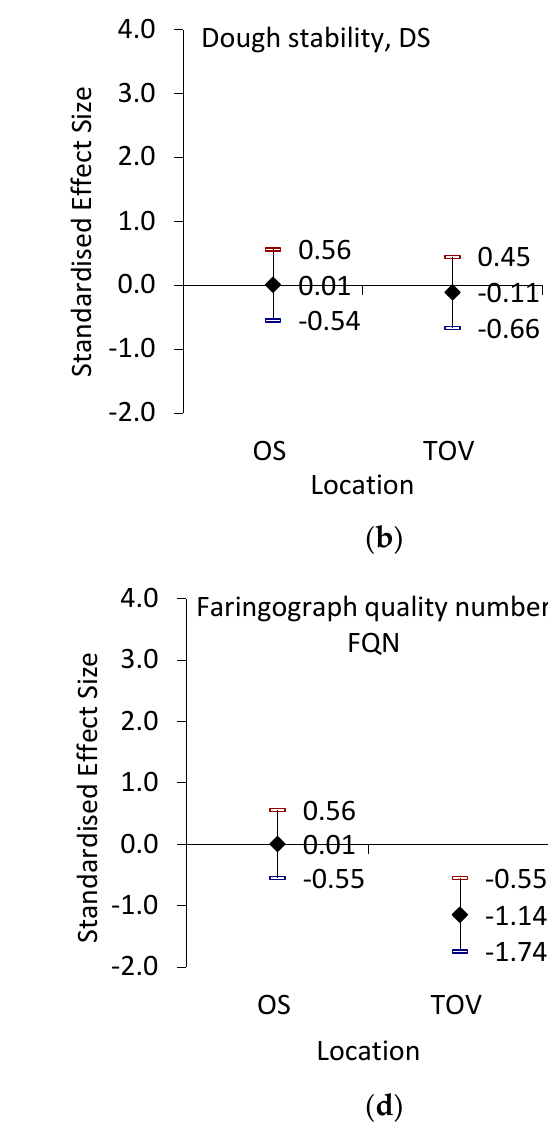
Figure 4. Estimates of standardized effect size with a 95% confidence interval of Fusarium infection impact on farinograph rheological properties: water absorption ( a ), dough stability ( b ), degree of dough softening ( c ), and farinograph quality number ( d ) of winter wheat cultivars grown at Osijek (OS) and Tovarnik (TOV) locations.